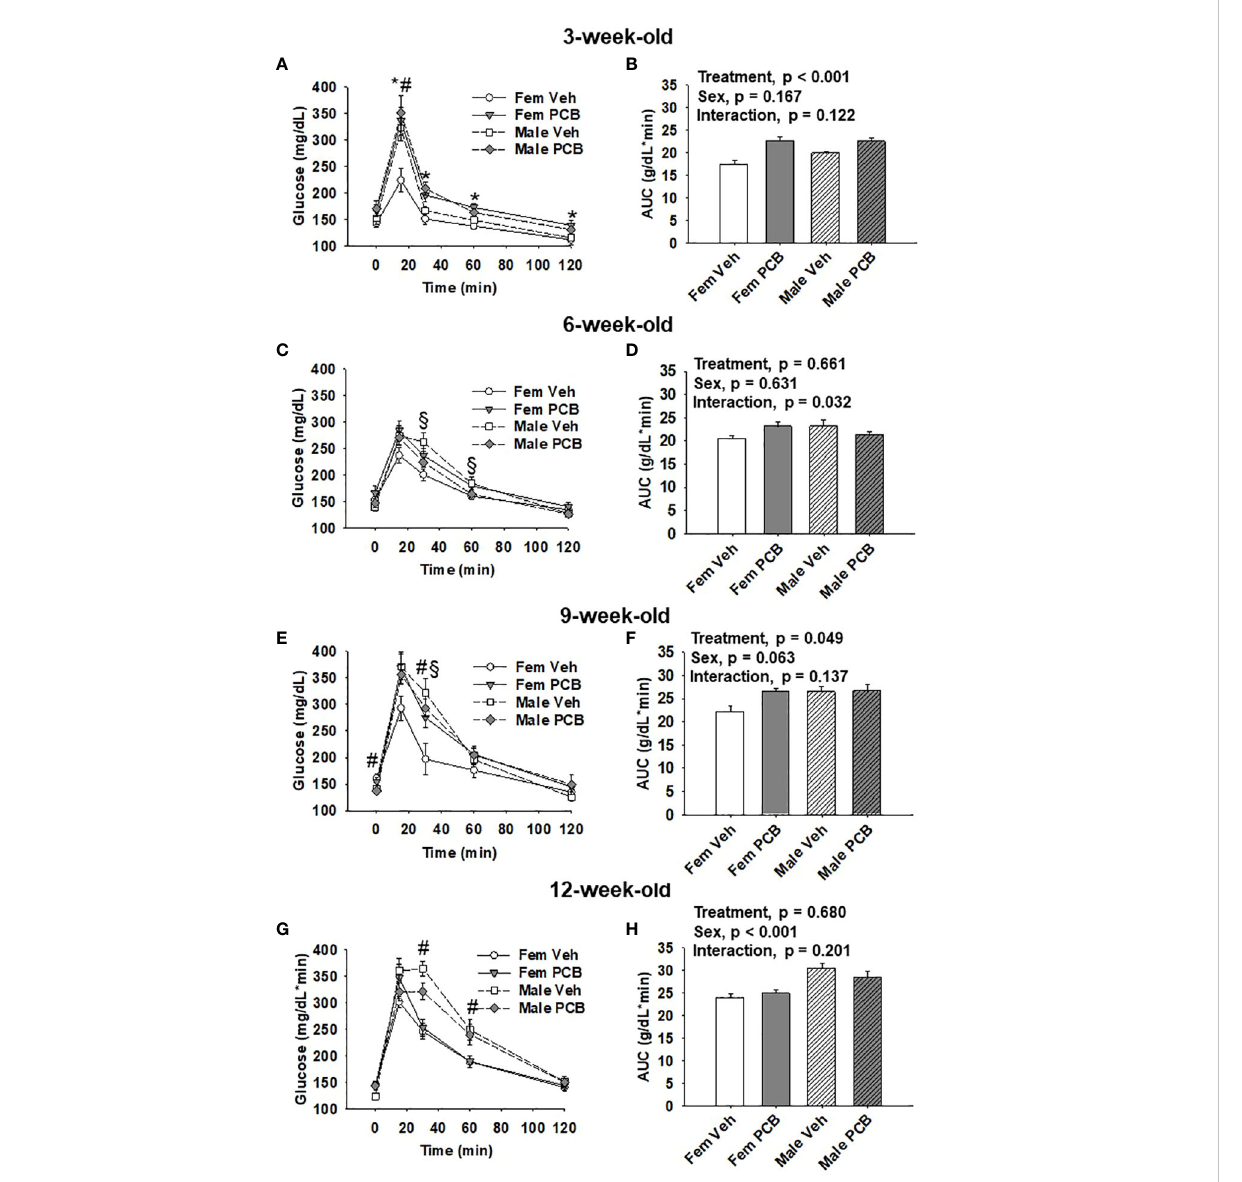
FIGURE 3 Offspring born to PCB126-exposed dams exhibit short-term impairments in glucose tolerance. Measurements of glucose levels in offspring are shown in response to intraperitoneal glucose injection. The glucose tolerance testing of (A) 3-week-old, (C) 6-week-old, (E) 9-week-old, and (G) 12-week-old vehicle- and PCB-exposed offspring. Signi fi cant sex-speci fi c differences and treatment differences in glucose tolerance were respectively observed in male offspring and PCB126-exposed offspring ( A , E , and G ; p < 0.05 for all). Total AUC of (B) 3-week-old and (D) 6-week- old, (F) 9-week-old, and (H) 12-week-old vehicle- and PCB-exposed offspring blood glucose levels are shown. Signi fi cant differences in treatment were observed in offspring at 3 weeks of age ( B , p < 0.001) and 9 weeks of age ( D , p = 0.049), while signi fi cant differences in sex was observed at 12 weeks of age ( H , p < 0.001). Values are shown as the mean ± SEM (n = 9 per group). Two-factor ANOVA was used to analyze glucose tolerance and AUC data. Speci fi cally, two-factor ANOVA was used at each time-point for glucose tolerance data analyses. The # sign designates a main effect of sex while the * designates a main effect of PCB treatment (P < 0.05). Signi fi cant interactions between treatment and sex are indicated by